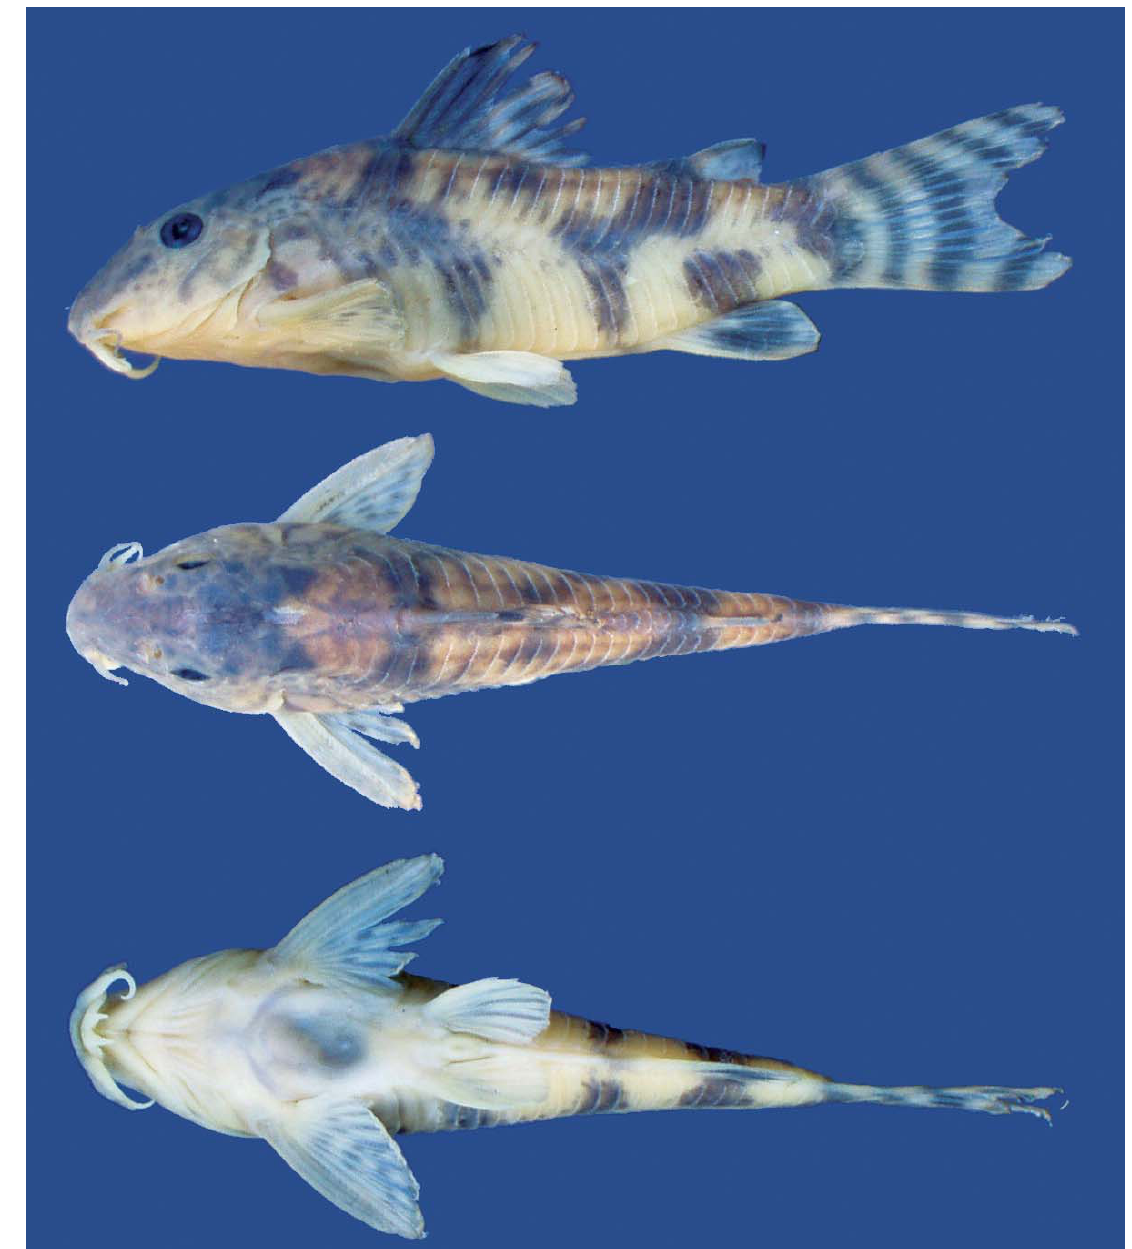
Fig. 1. Scleromystax salmacis , holotype, MCP 38388, female, 36.7 mm SL, arroio Molha Coco, Praia Grande, Santa Catarina,